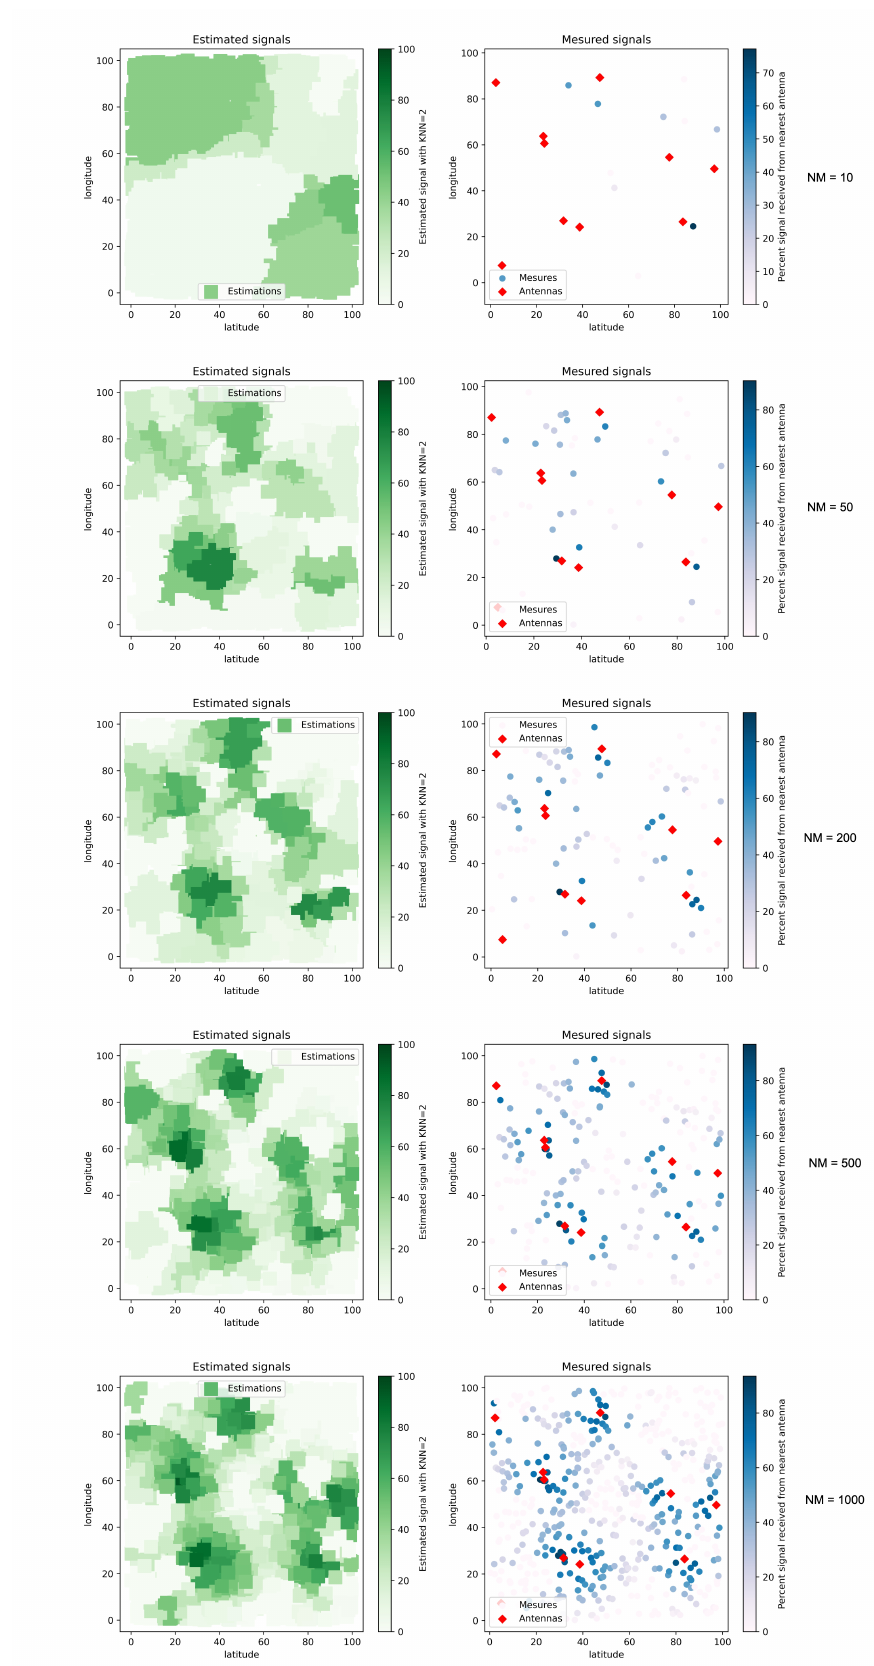
Figure 11. Signal estimations with different numbers of signal (NM) measures and